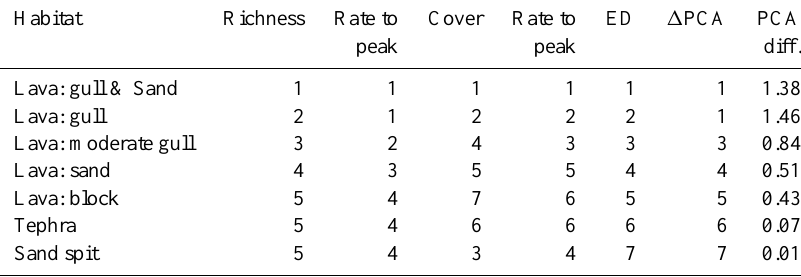
Table 5. Relative ranking of succession rates on Mount St. Helens using several criteria. Habitat Richness Rate to Cover Rate to ED PCA peak peak diff. Lahar: Near Pumice: low 1.49 Pumice: